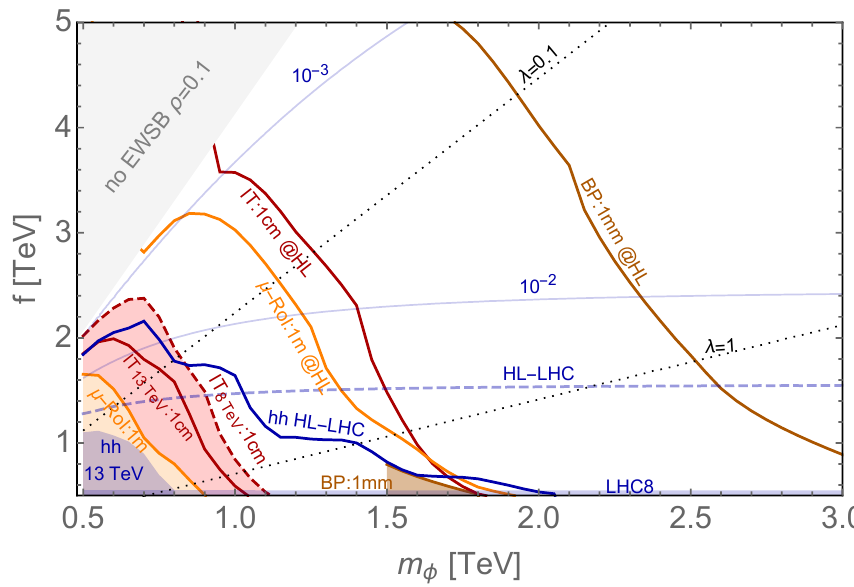
Figure 6 . Parameter space of the Fraternal Twin Higgs model as a function of the Twin Higgs mass, m (cid:30) , and f overlaid with current and projected constraints from direct searches. We vary (cid:14)y b and (cid:14)g in order to (cid:12)x the lightest glueball mass to 50 GeV across the entire parameter space and simultaneously single out representative values of c(cid:28) (see text for details). We assume that 100% of the t B (cid:22) t B and Z B Z B pairs from the decays of the Twin Higgs eventually decay into glueballs. Solid blue lines indicate the value of sin 2 (cid:13) , while the dashed black lines correspond to constant values of the SU(4)-symmetric quartic, (cid:21) . The gray shaded region cannot produce EWSB for (cid:26) = 0 : 1. The orange shaded region indicates the exclusion from the 13 TeV ATLAS muon RoI search for c(cid:28) = 1 m for the lightest glueball. The assumptions about the glueball production modes are detailed in the text. The red shaded indicates the exclusion for the CMS IT search at 13 TeV with c(cid:28) = 1 cm. For the same decay length, we show as a dashed red line the extrapolation of the 8 TeV search. The dark orange shaded region shows the exclusion from the CMS BP search at 13 TeV for c(cid:28) = 1 mm. The orange, red and dark orange lines are projections of the displaced searches to HL-LHC under the assumption of zero background. The small blue shaded region on the lower left corner of the (cid:12)gure indicates the exclusion from resonance di-Higgs production, which is stronger than the ZZ searches in this case. The blue line shows the projections at HL-LHC. The blue shaded horizontal band at low values of f is probed by 8 TeV Higgs coupling measurements, while the light blue dashed line shows the corresponding extrapolation to the